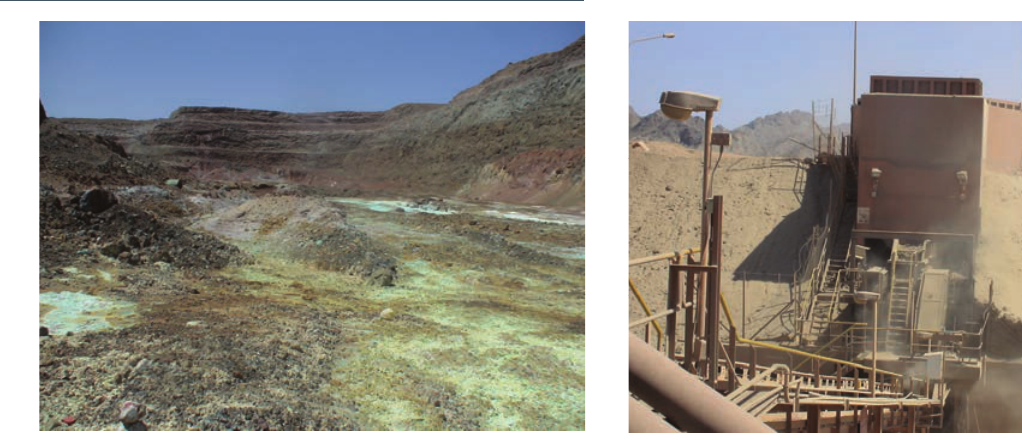
Figure 2. Photograph shows the open pit.